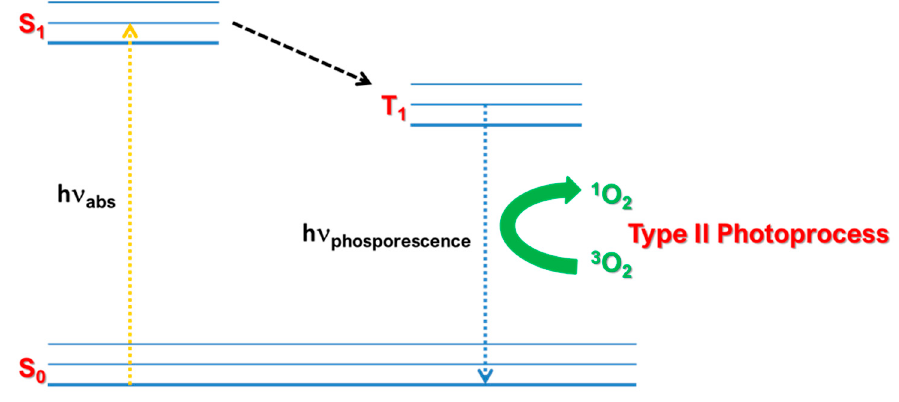
Figure 25. Schematized Jablonski’s diagram for a typical PS.